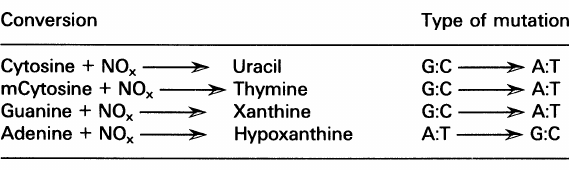
Table 3. Types of alterations and mutations that may arise from the deamination of DNA bases Conversion Type of